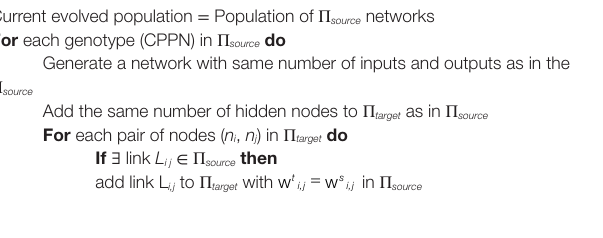
algOriThM 2 | Collective Behavior Policy Transfer.